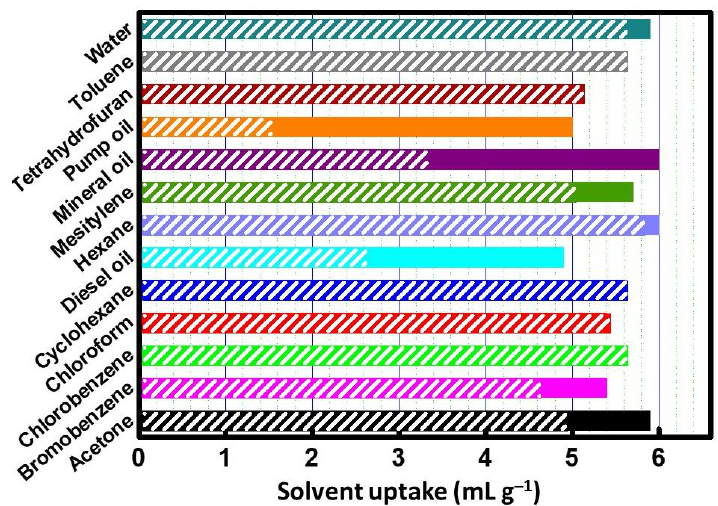
Figure 4. Solvent adsorption by X-Ca-alginate aerogel beads at 10 min (shaded length of each column) and at the time of maximum adsorption, i.e., 1 h for all solvents in Table 1, 1.5 h for diesel oil, 2.5 h for mineral oil, and 4 h for pump oil (full length of each